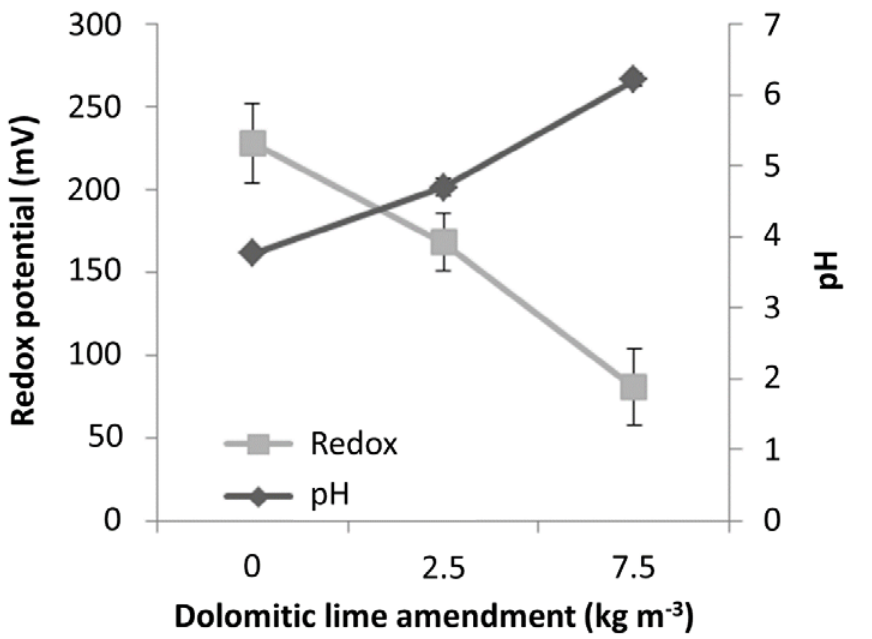
Figure 6. Effects of dolomitic lime treatments on the redox potential and pH in peat surrounding the root zone (mean ± SE) in the greenhouse. Soil data for both species ( C. paleacea and S. pectinata ) are included in the means ( n = 30). See Table A4 for results of the statistical